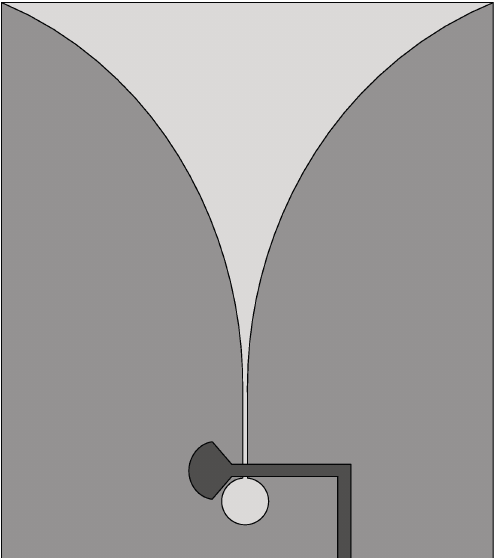
Figure 3. Basic design structure of Vivaldi antenna (redrawn from [40]). Dark gray top metal face, medium gray bottom metal face, and light gray dielectric